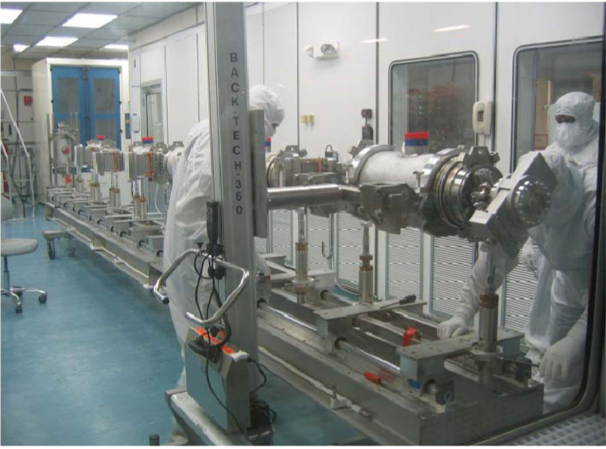
FIG. 30. Annotated oscilloscope image capturing the transition from self-excited-loop (SEL) to generator-driven-resonator (GDR) control with piezotuner enabled (from [157]).